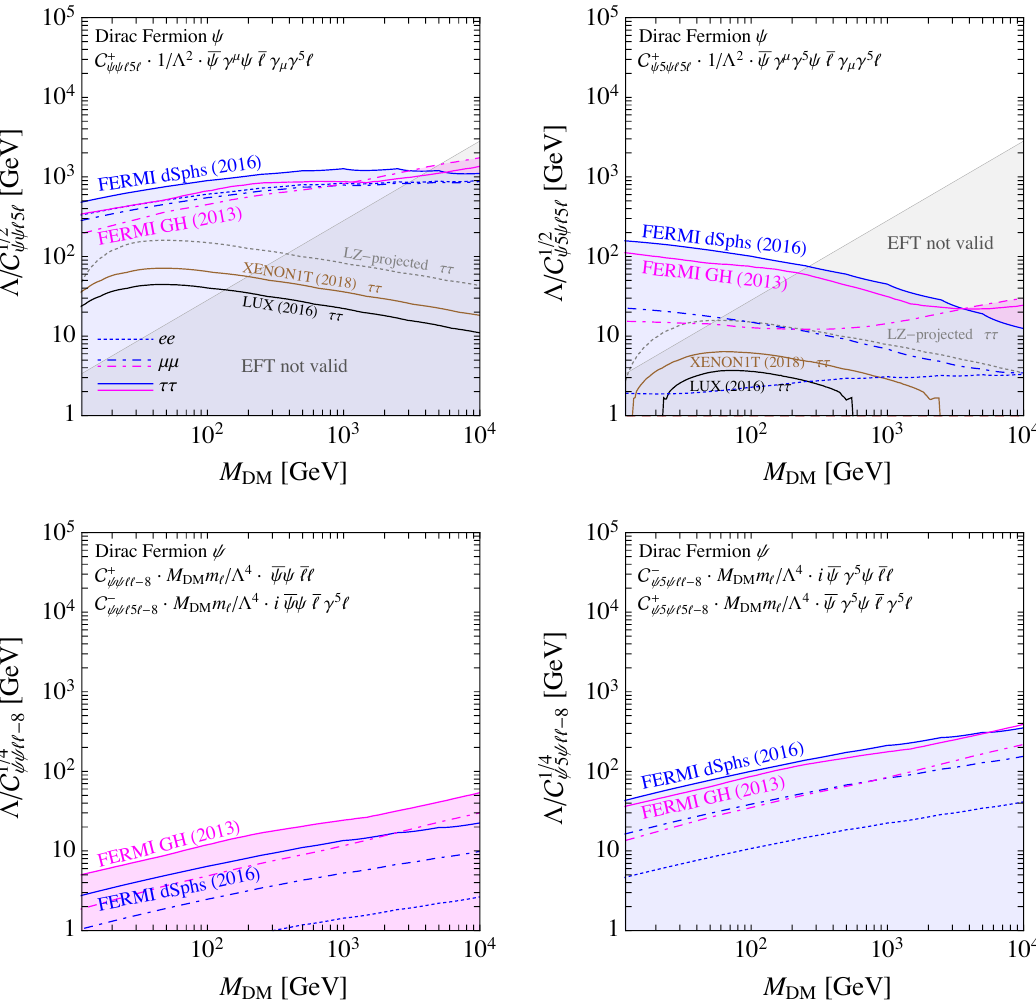
Figure 4 . Constraints from direct and indirect detection on UV-related operators for Dirac Fermion